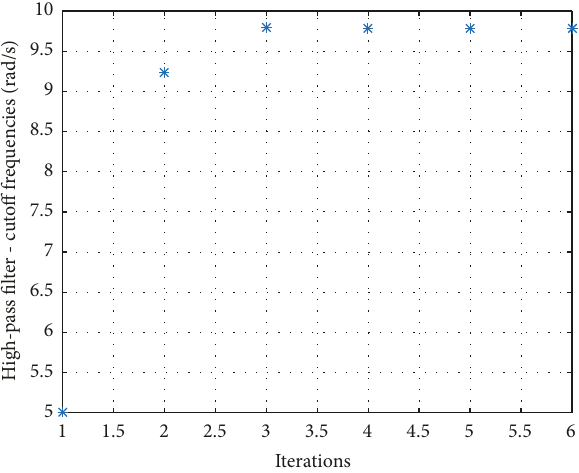
Figure 7: Evolution of cut-off frequencies: high-pass filter.